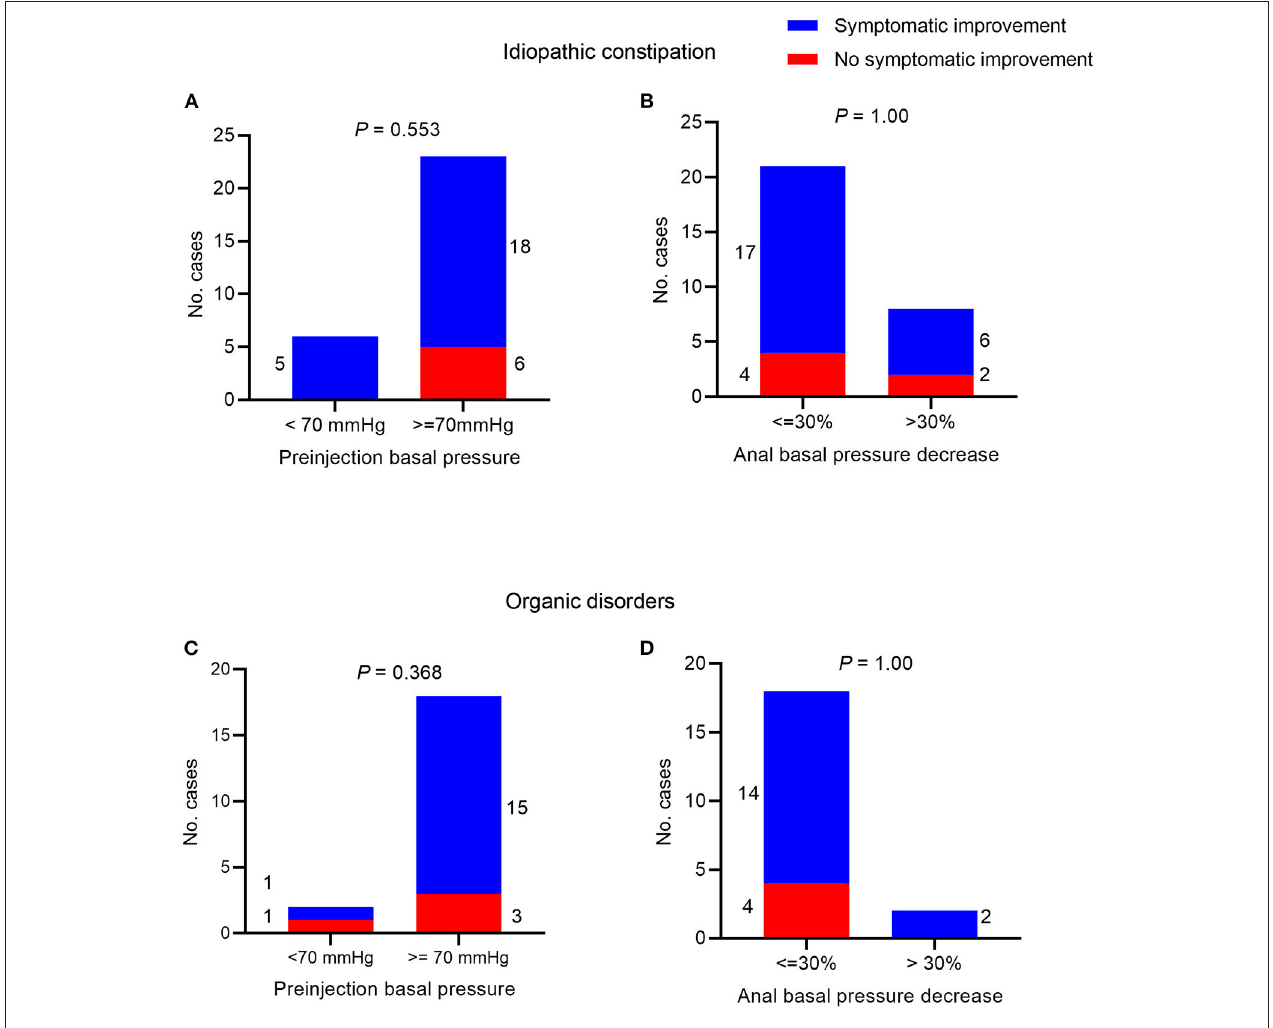
FIGURE 3 | Symptomatic improvement after botulinum toxin injection. In patients with idiopathic constipation and Chi-square test between symptom improvement and (A) preinjection anal basal pressure < 70 mmHg/ ≥ 70 mmHg; (B) decrease of anal basal pressure ≤ 30/ > 30% post-injection. In patients with organic disorders and Chi-square test between symptom improvement and (C) preinjection anal basal pressure < 70 mmHg/ ≥ 70 mmHg; (D) decrease of anal basal pressure ≤ 30%/ > 30%